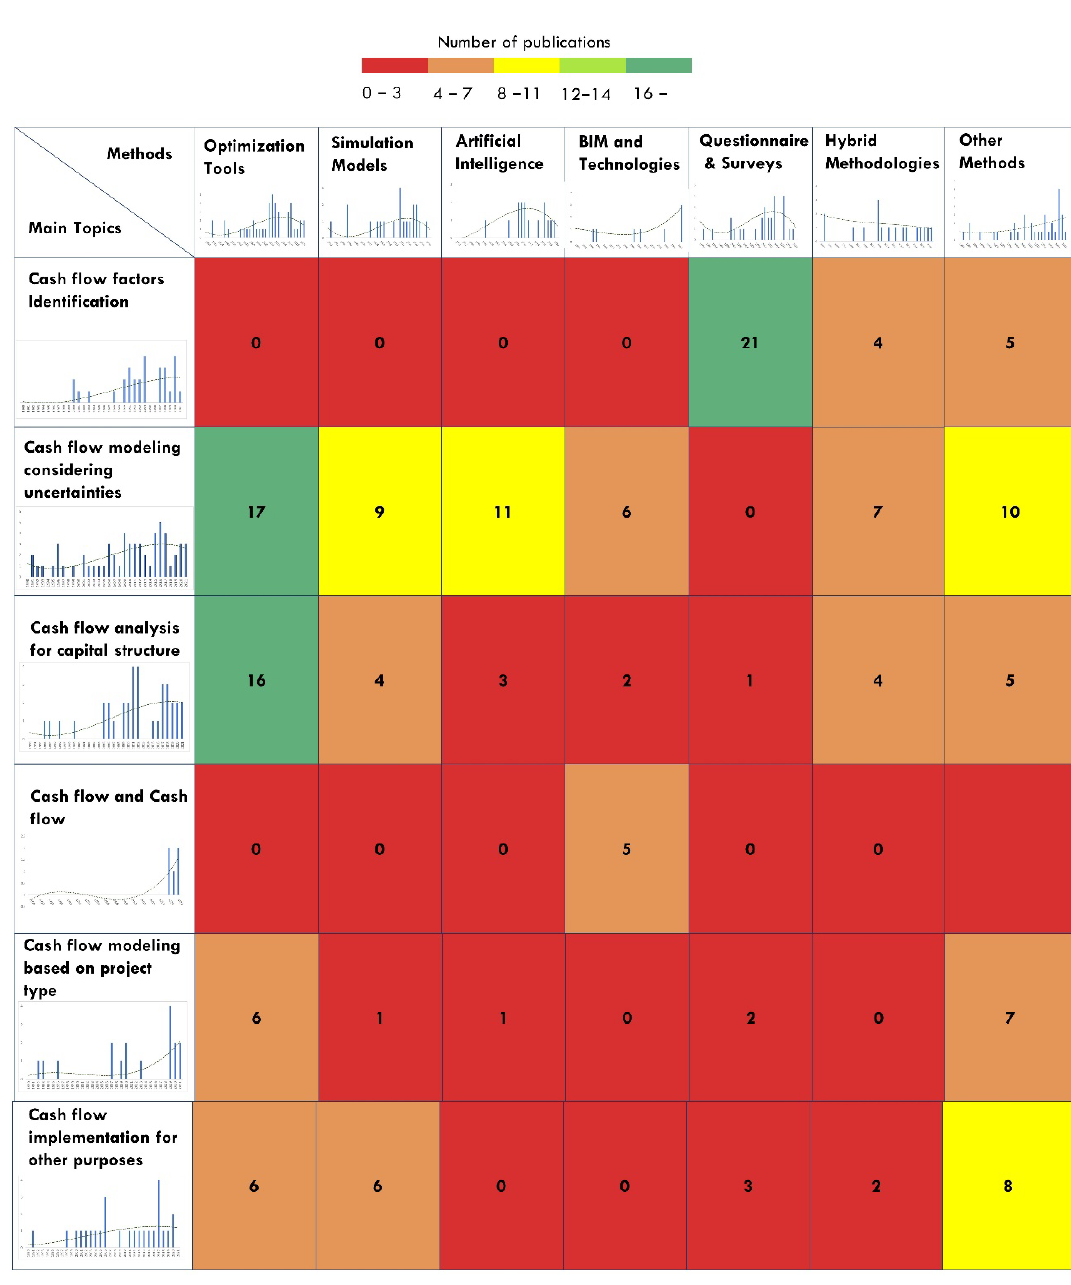
Figure 10. A two-dimensional classification matrix of main topics and methods regarding cash flow analysis .